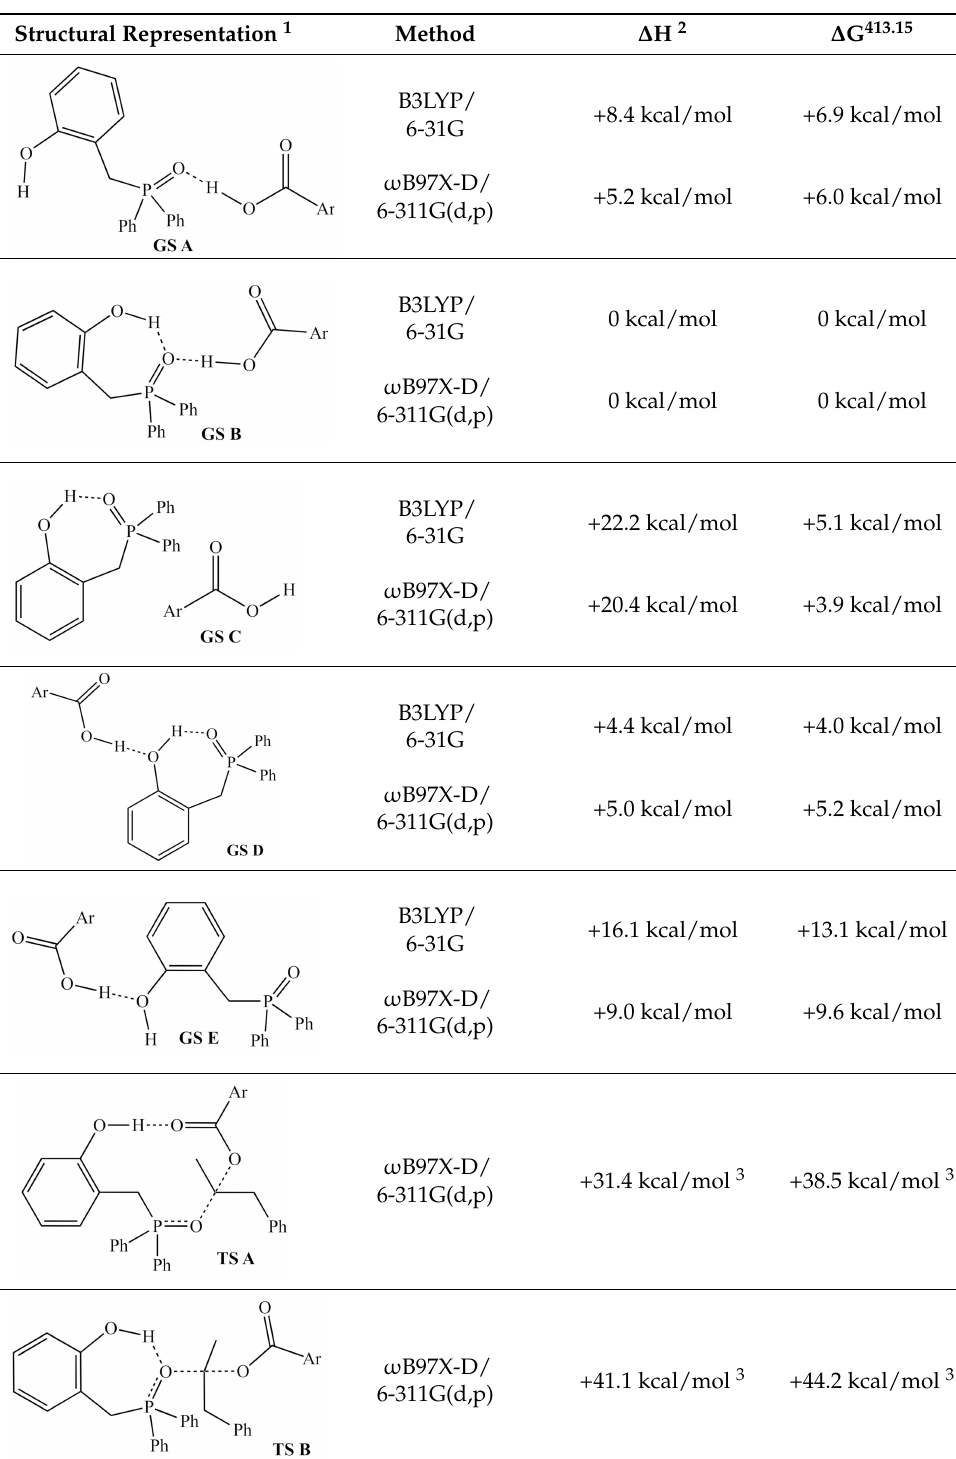
Table 1. Possible turnover-limiting ground state and transition state structures for the 1a -mediated reaction of 2,4-DNBA and